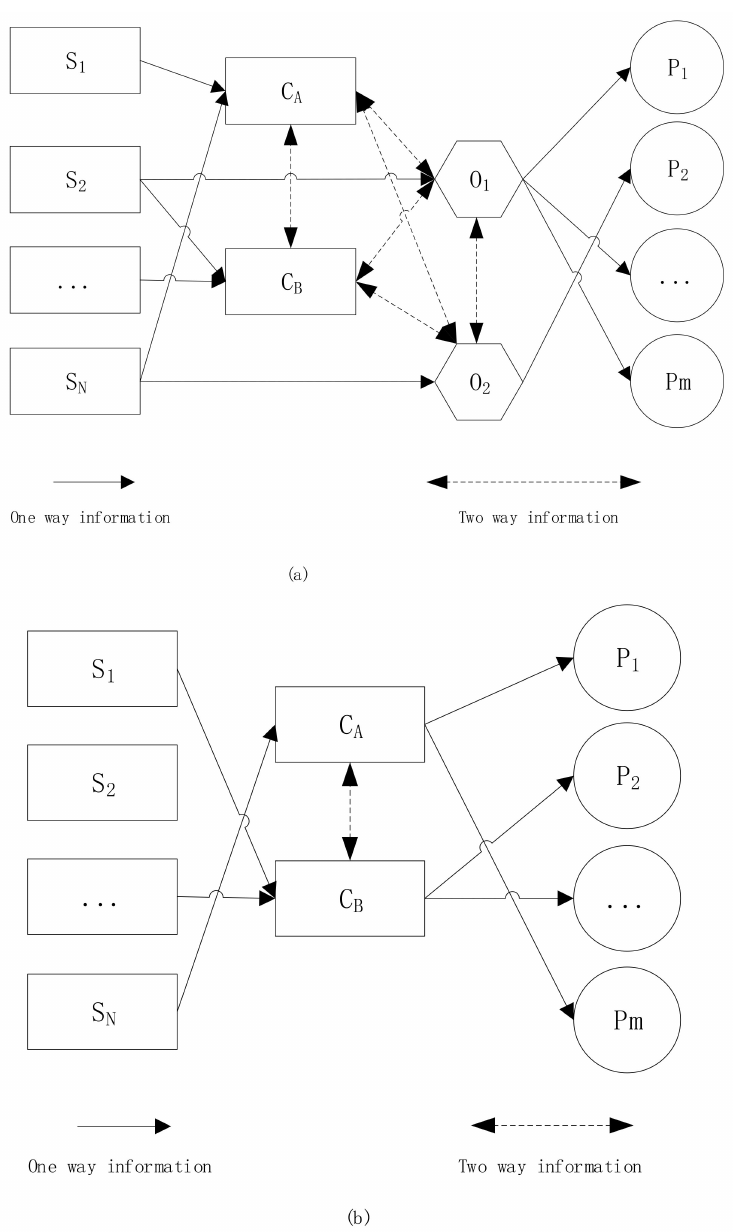
Figure 1. Flow Pattern of the Disaster Information in Social Media: ( a ) Information Flow Pattern of Man-made disaster; ( b ) Information Flow Pattern of Natural